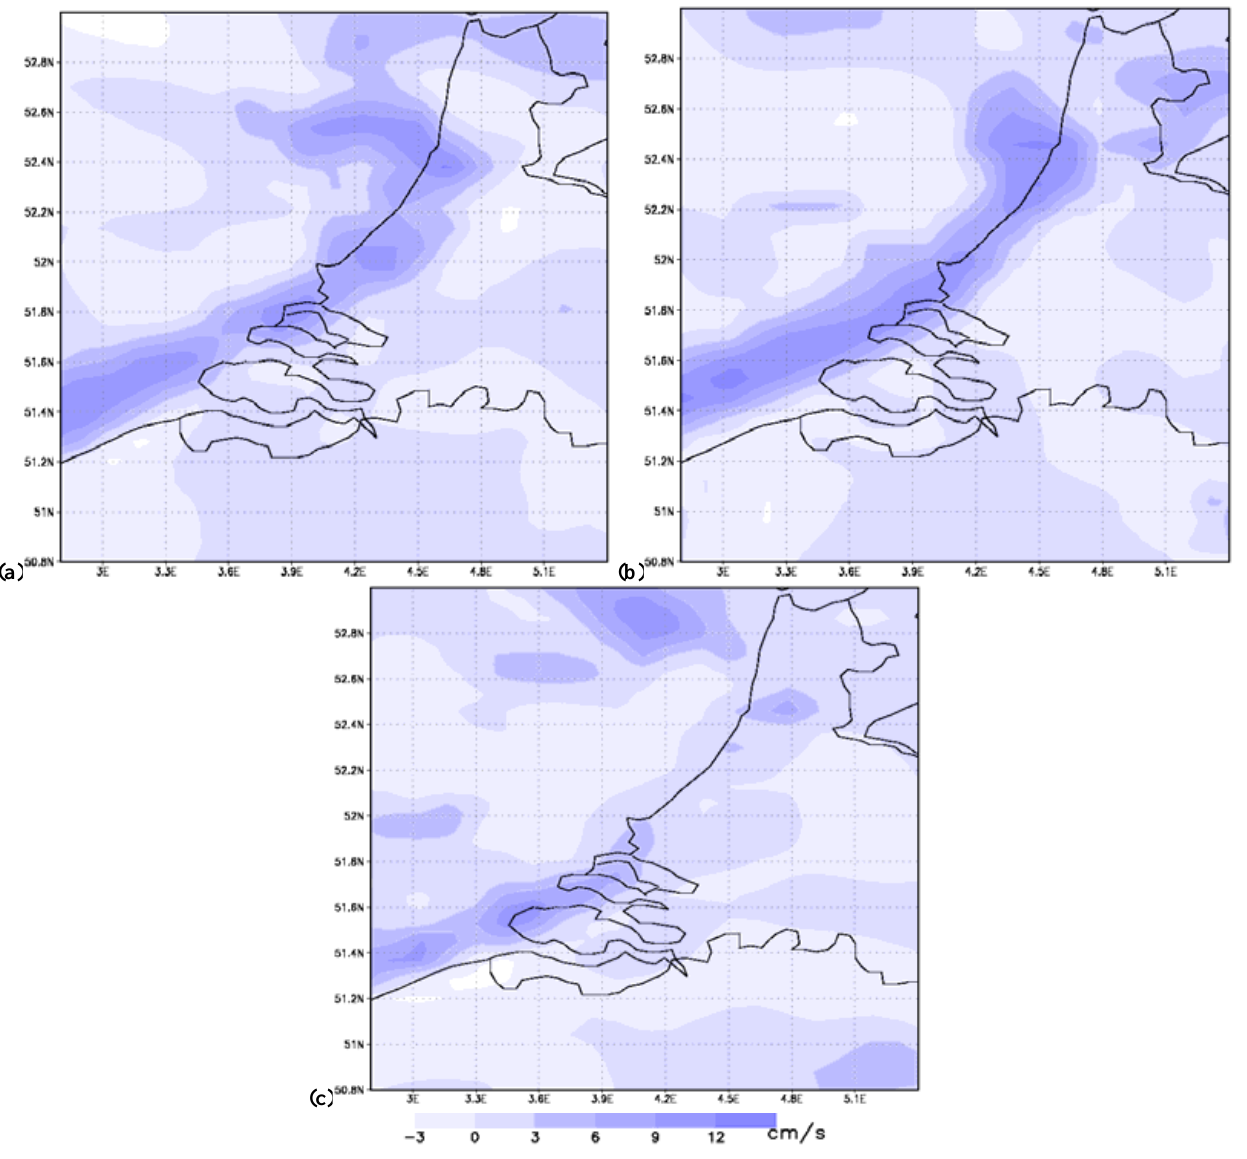
Fig. 12. Vertical wind speed (cm/s) at σ =0.9, derived from simulations 2 (a) , 3 (b) and 5 (c) . Specifications of the simulations are written